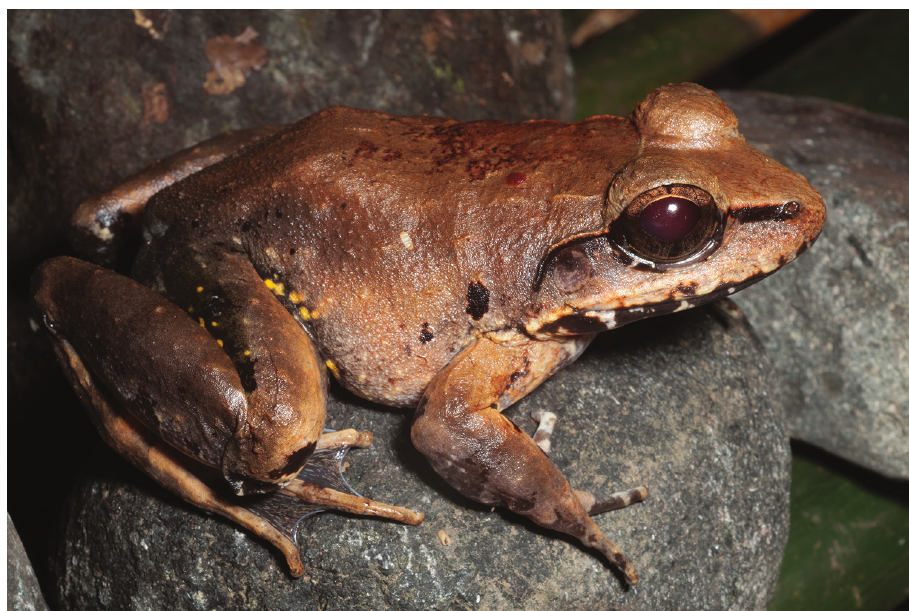
Figure 15. Limnonectes cf. magnus female (KU 333351) from Eye Falls, Mt. Hilong-hilong, Municipality of Remedios T. Romualdez, Agusan del Norte Province. Photo: